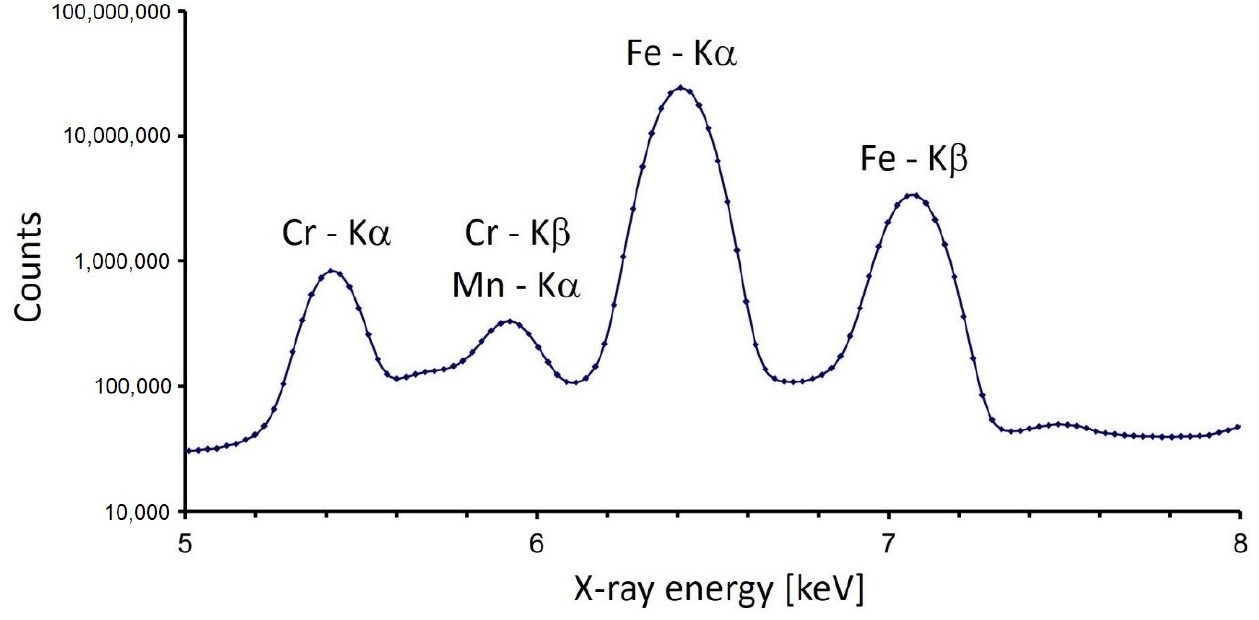
Figure 2. Sum spectrum from the XRF scanning of a modern steel ball